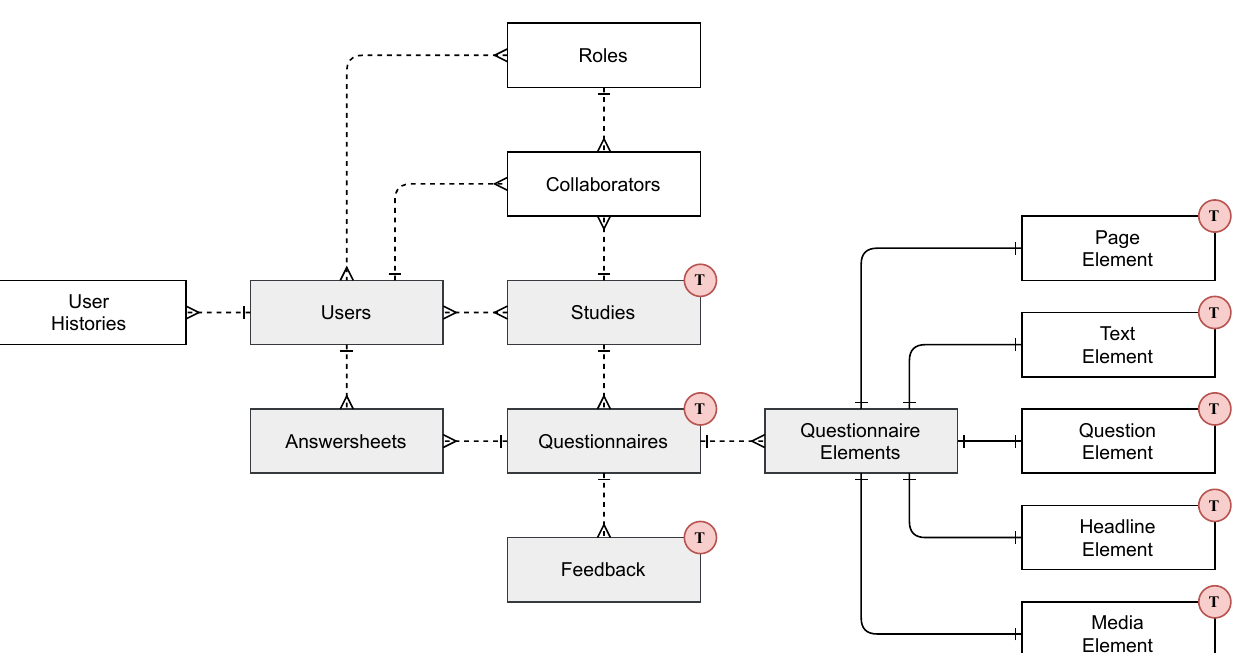
Figure 6. Excerpt of Corona Health’s relational database schema. The circled T (cid:13) indicates the presence of translated text